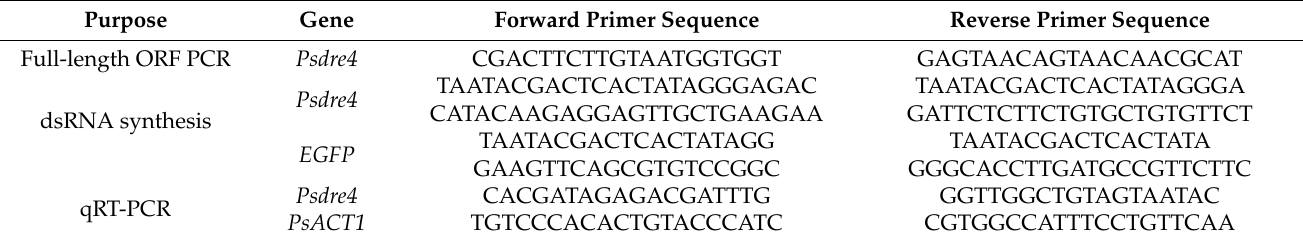
Table 1. List of primers used in the